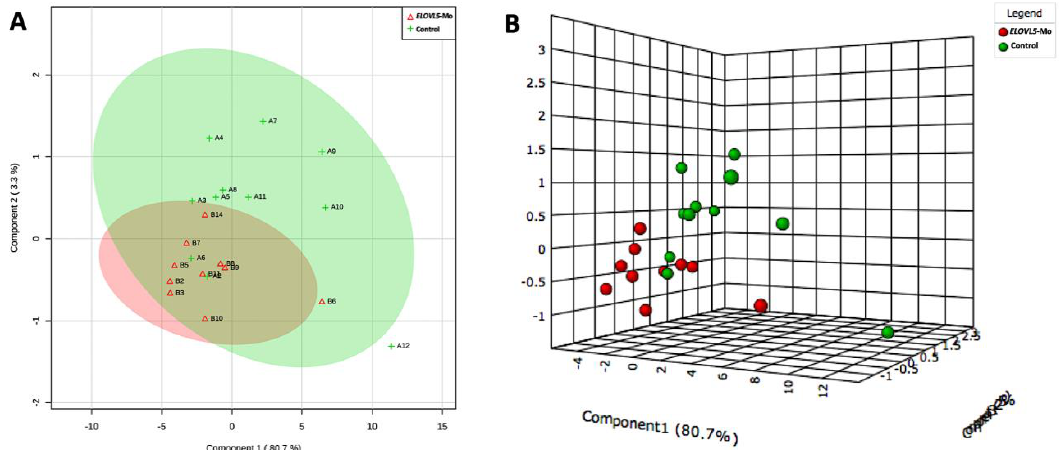
Figure 5. Two- ( A ) and three-dimensional ( B ) partial least squares discriminant analysis (PLS-DA) plots from the MALDI-MS lipid profile data of the biological control and ELOVL5 -Mo–derived in vitro-produced bovine embryos. Light green and light red colors ( A ) represent the 95% confidence region of the control and ELOVL5 -Mo groups, respectively. Each colored dot represents the lipid fingerprint of an individual sample group ( A , B ). n = 15 per group. Table 3. Downregulated lipid species identified via MALDI-MS in ELOVL5 -Mo–derived blastocysts. m/z Lipid Ion (Carbons: